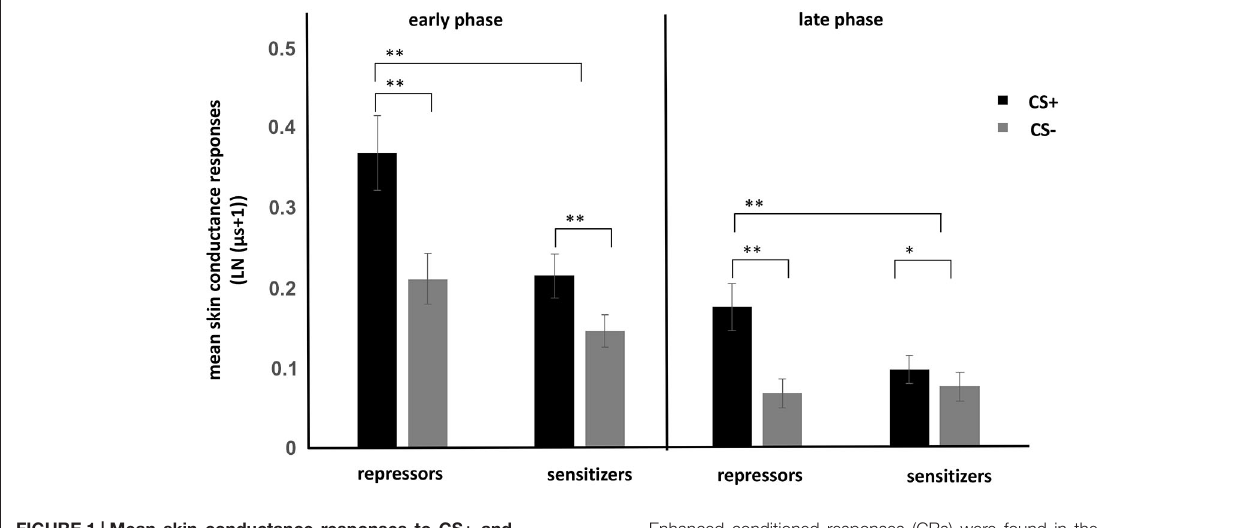
FIGURE 1 | Mean skin conductance responses to CS+ and CS − for repressors and sensitizers for the early (first half of conditioning) and late phase (second half of conditioning)